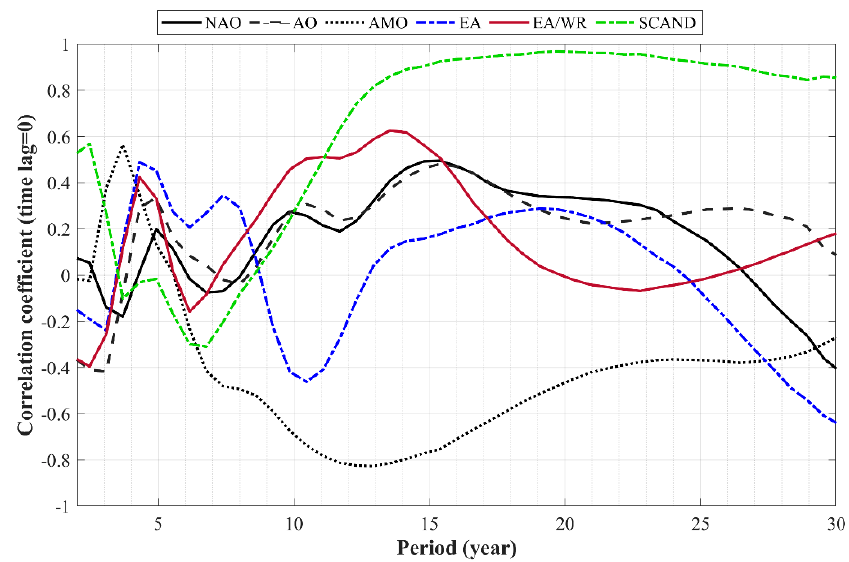
Figure 9. Wavelet correlation coefficients for fluctuations of maximum annual wave height and climate indices: the North Atlantic Oscillation (NAO), the Atlantic Multi-decadal Oscillation (AMO), the East Atlantic Oscillation (EA), the Arctic Oscillation (AO), the East Atlantic-Western Russia (EA/WR) and Scandinavian (SCAND).